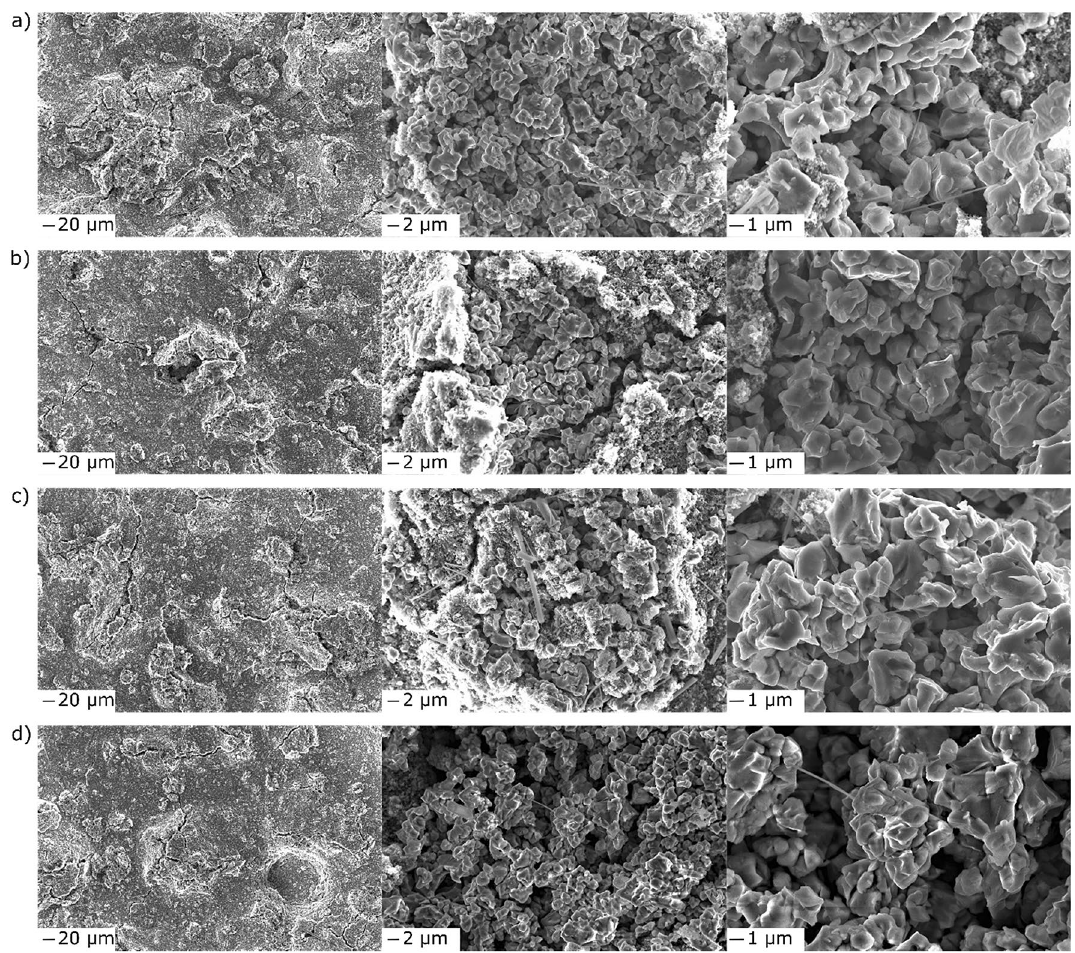
Figure 3. Top-view SEM images at different magnifications of the HEO anode ( a ) at 1.0 V, ( b ) 1.8 V and ( c ) 2.5 V vs Li + /Li in the initial delithiation cycle and ( d ) after the first five